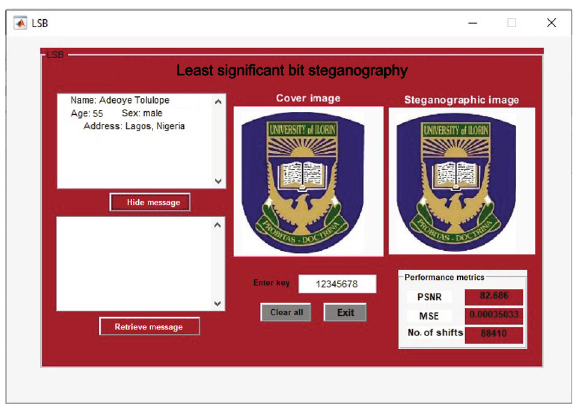
Figure 5: Interface of the embedding